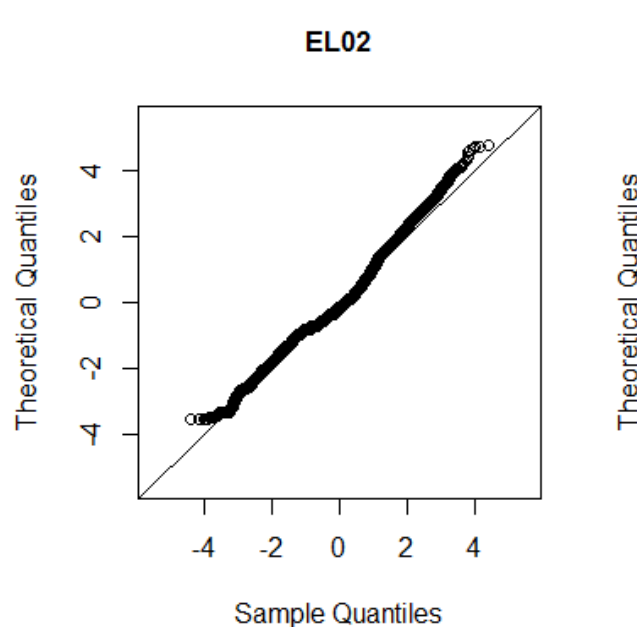
Figure 5. Quantile-quantile plots of ordinary normal pseudo-residuals in model scheme M2 for EL02 and